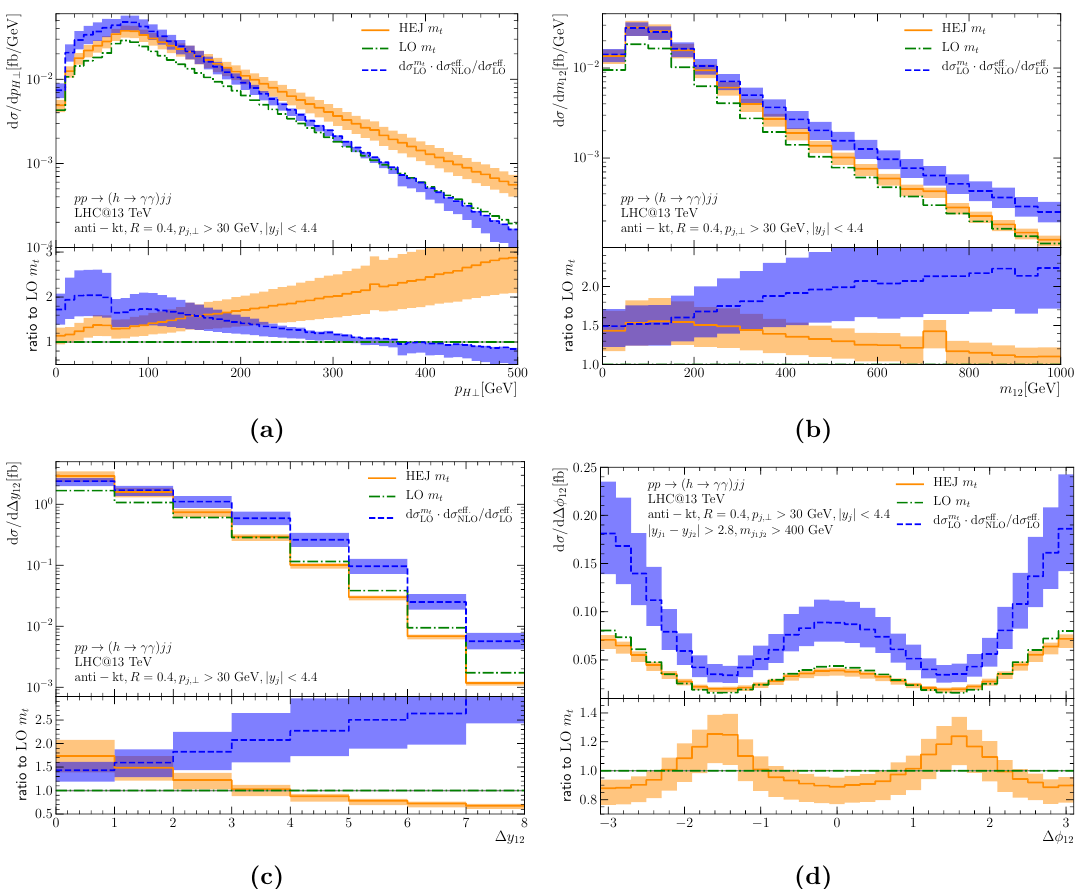
Figure 9 . The results obtained from HEJ (orange, solid) and LO (green, dot-dashed) both with full top mass. Additionally in blue, dashed is the result of scaling the LO full m t -result bin-by-bin with the NLO K -factor in the m t limit. The K -factors and their impact within the VBF cuts ! 1 (applied in (d)) are discussed in the text.